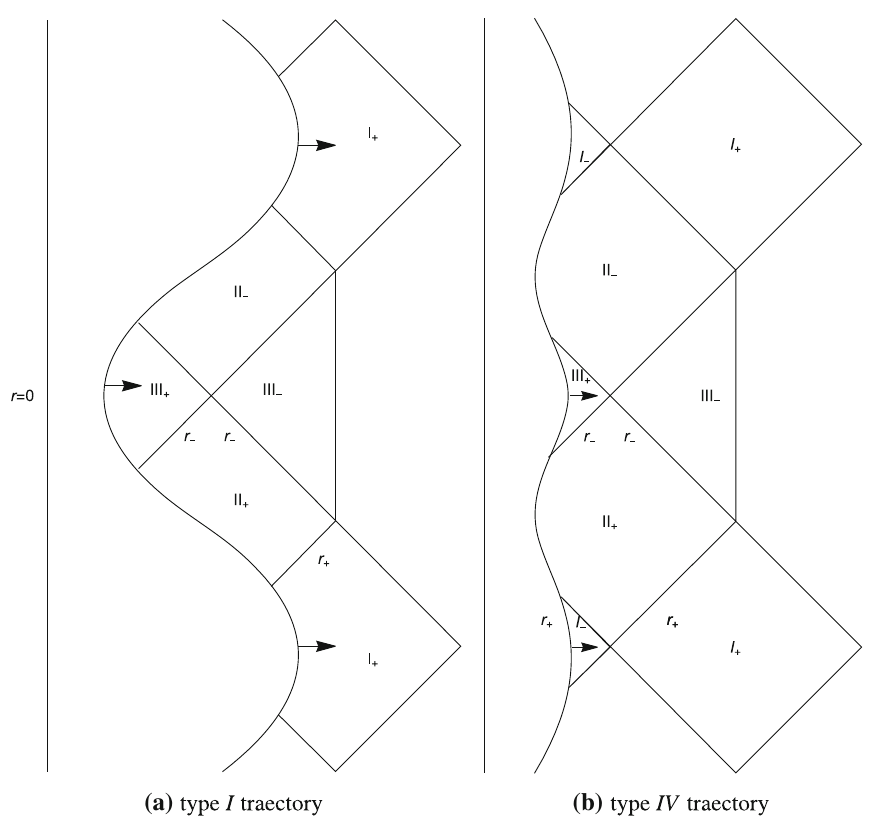
Fig. 2 The different types of the oscillating shell’s trajectory on Penrose diagram are plotted